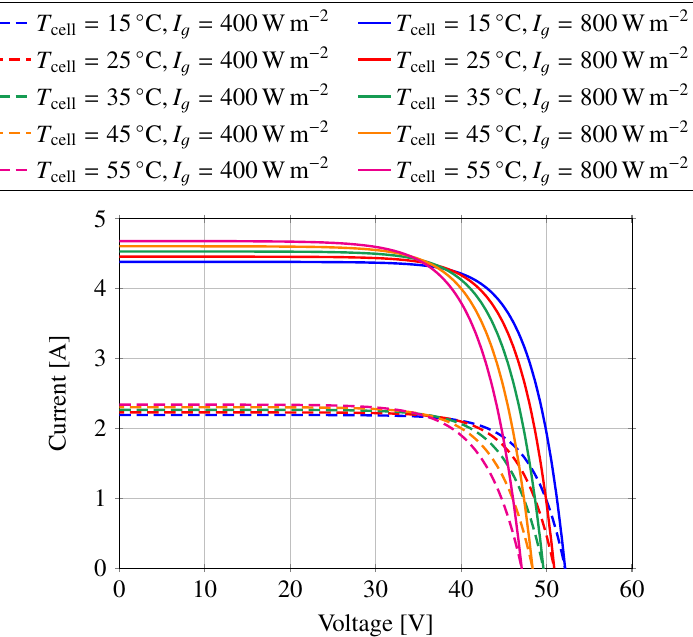
Figure 4. I - V characteristics of the considered PV panel for various cell temperatures and for a solar irradiation of 400W/m 2